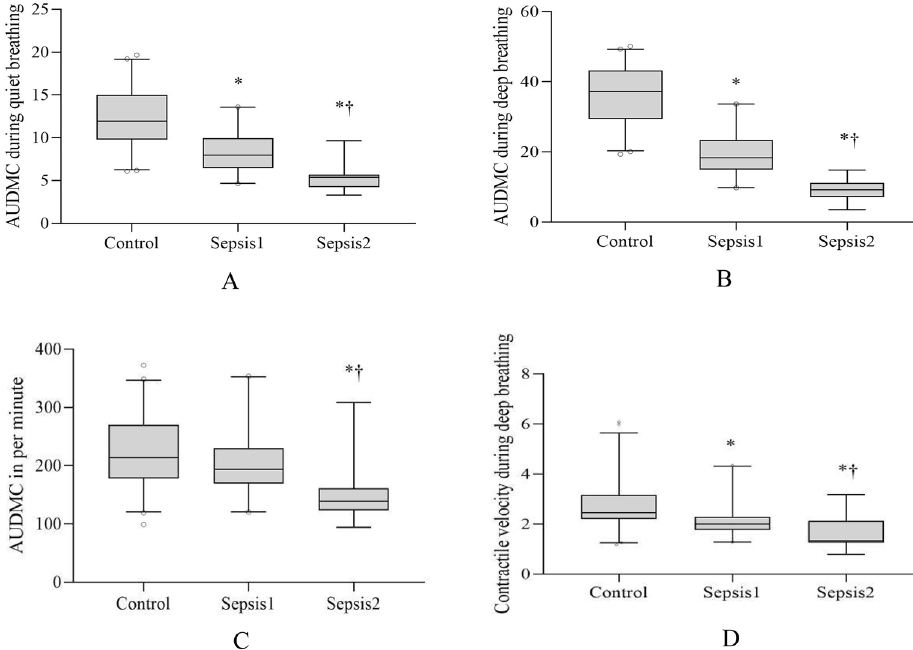
Figure 3. AUDMC during quiet breathing ( A ), AUDMC during deep breathing ( B ), AUDMC in per minute ( C ), Diaphragm contractile velocity ( D ). * P < 0.05 compared with control group; † P < 0.05 compared with sepsis group